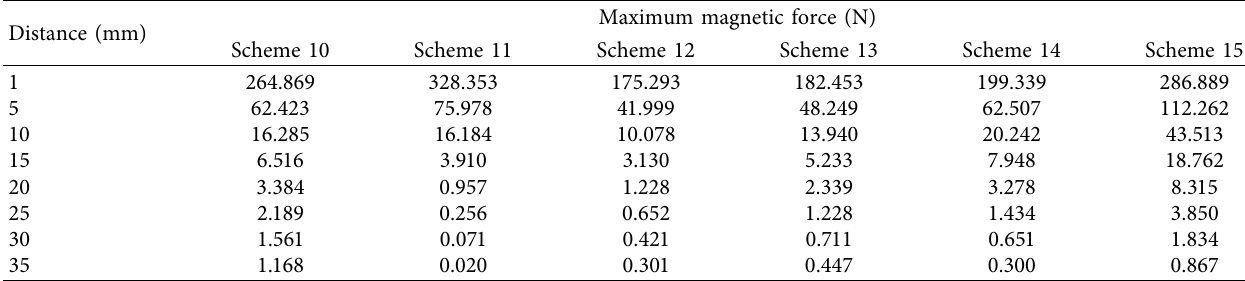
Maximum magnetic force